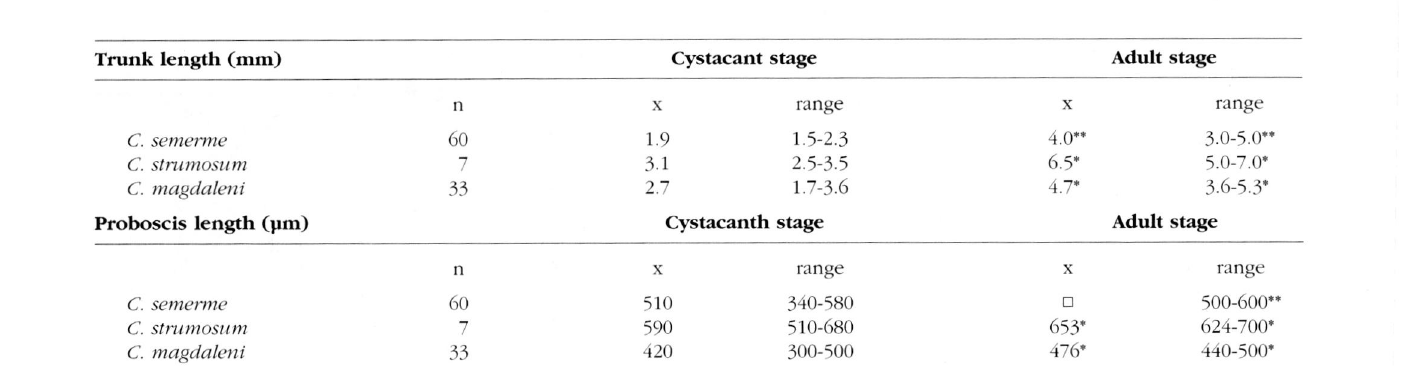
Table II. - The proportion of Corynosoma species in fourhorn scul­ pins in the Bothnian Bay in 1996-1997 (number of fish = 340).